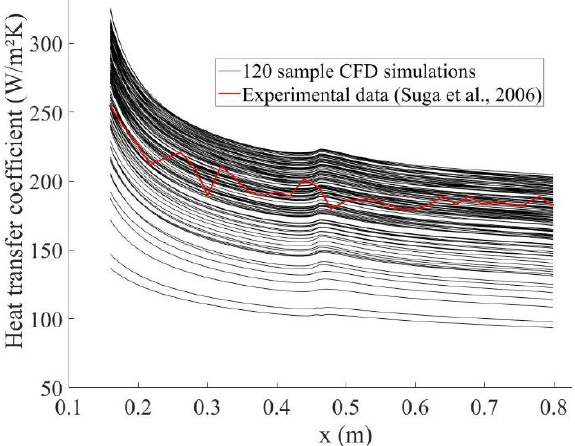
Figure 5. Database of heat transfer coefficients obtained with the DOE.